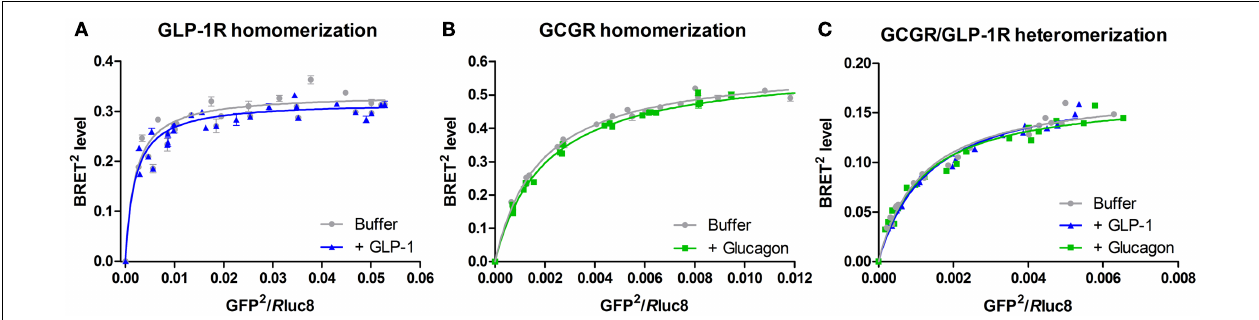
FIGURE 2 | Bioluminescence resonance energy transfer saturation studies on homo- and heteromerization of GLP-1R and GCGR. These BRET studies were performed as BRET 2 saturation assays, which uses a spectrally improved form of the luciferase enzyme substrate (coelenterazine), DeepBlueC, as well as a modified form of the energy acceptor, GFP 2 (Pfleger and Eidne, 2006). In addition, a mutationally improved energy donor, R luc8, with increased stability and quantum yield was used (De et al., 2007). HEK293 cells were transiently co-transfected with a constant amount of either GCGR- R luc8 or GLP-1R- R luc8 and an increasing amount of either GCGR-GFP 2 or GLP-1R-GFP 2 and incubated for 48h at 37˚C and 5% CO 2 . Subsequently, the cells were harvested, diluted to a concentration of 1 × 10 6 cells/ml, and stimulated with either 105nM GLP-1, 83.5nM glucagon, or buffer (negative